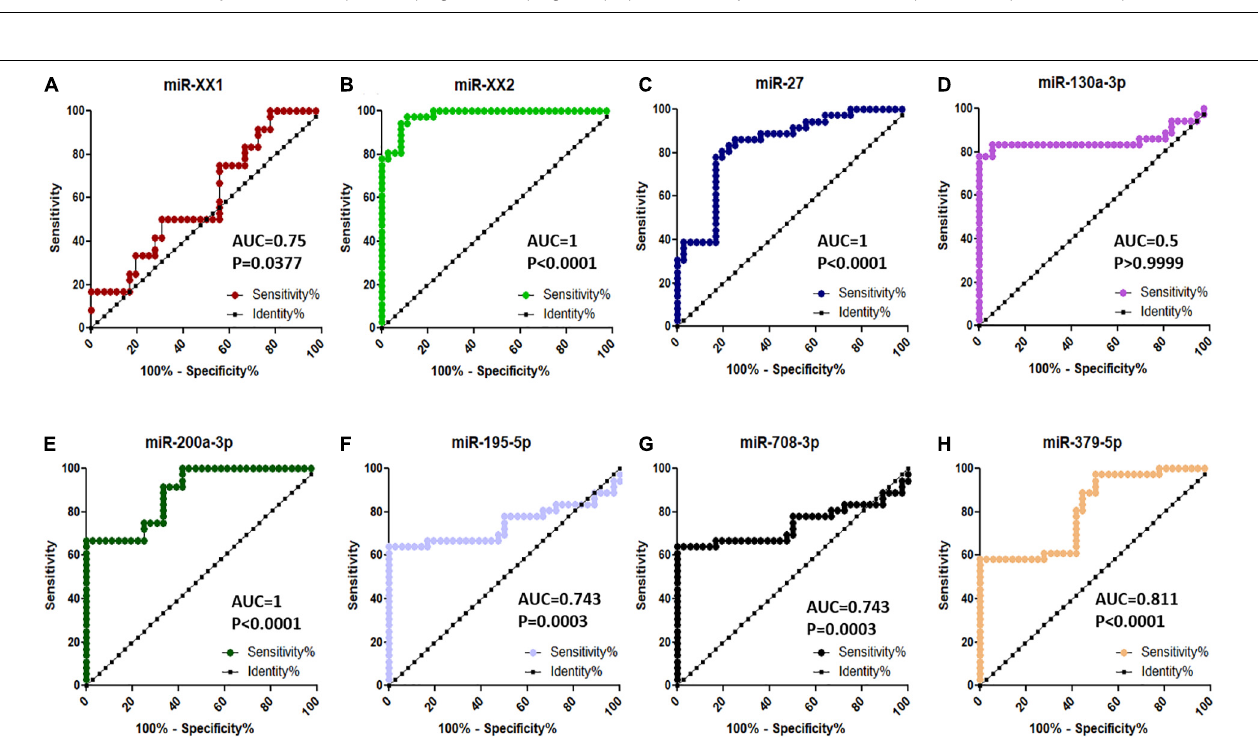
FIGURE 7 | ROC curve analysis of diagnostic value of circulating miRNA for pregnant vs. non-pregnant buffaloes: (A) miR-XX1, (B) miR-XX2, (C) miR-27, (D) miR-130a-3p, (E) miR-200a-3p, (F) miR-195-5p, (G) miR-708-3p, and (H) miR-379-5p. AUC, area under the curve; ROC, receiver operating characteristic.